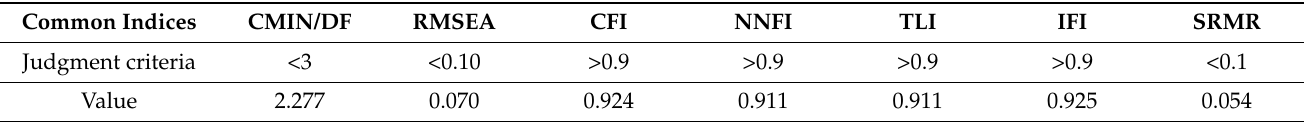
Table 4. Main test indicators for model